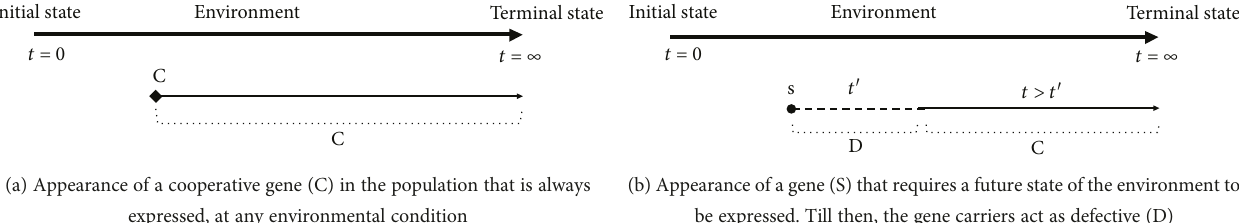
Figure 1: Silent genes: gene expression is often dependent on environmental factors. At their absence, the gene will stay unexpressed, although it can still be inherited and, in certain cases, spread in a population. The initial and terminal states here could represent low/high temperature, pH, or any combination of environmental triggers required for the activation of the gene in hand.